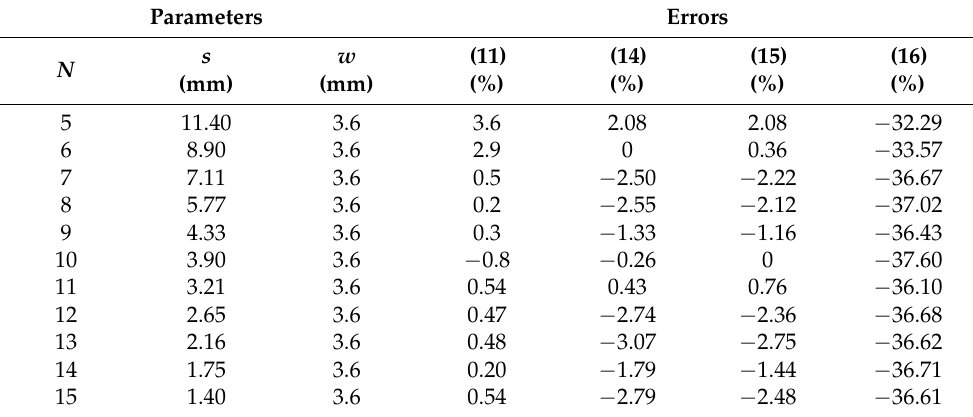
Table 4. Comparison results of Errors.